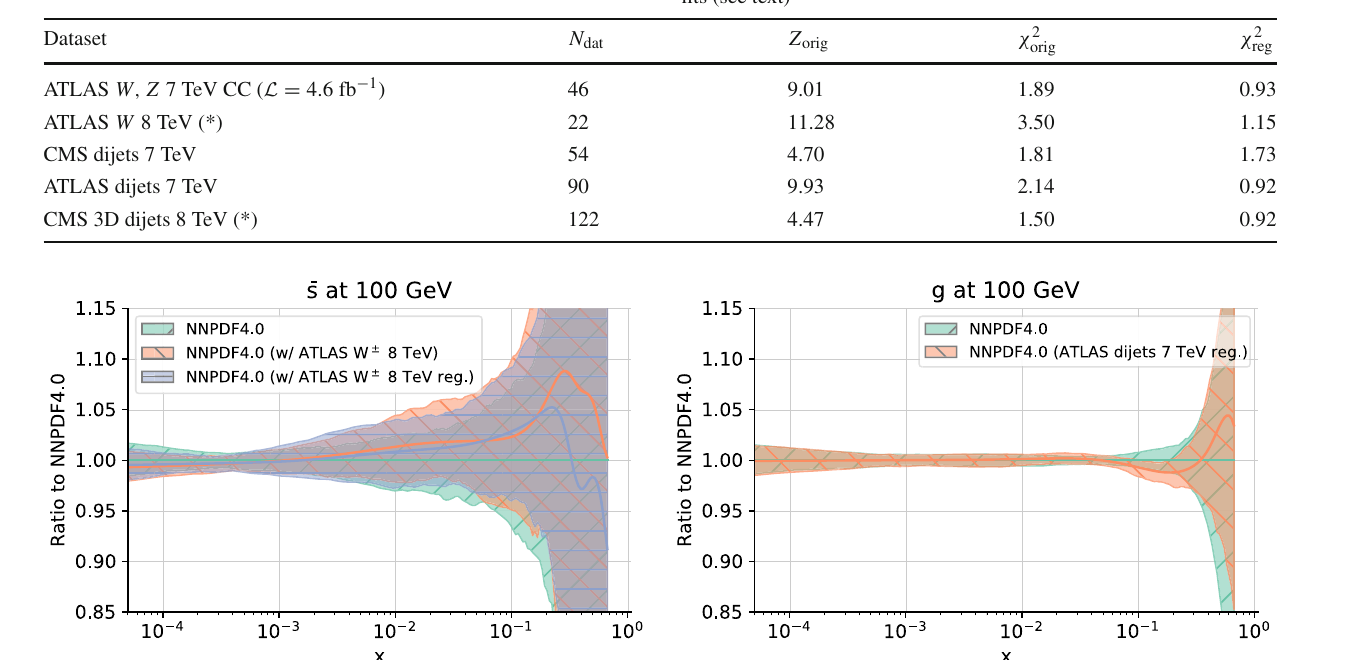
of the stability metric Z orig , and then the values of the χ 2 reg obtained by repeating the fit with the regularized covariance matrix for this dataset, for a choice of the target metric of Z reg = 4. Datasets denoted by (*) are not part of the baseline and have been obtained from dedicated PDF and orig